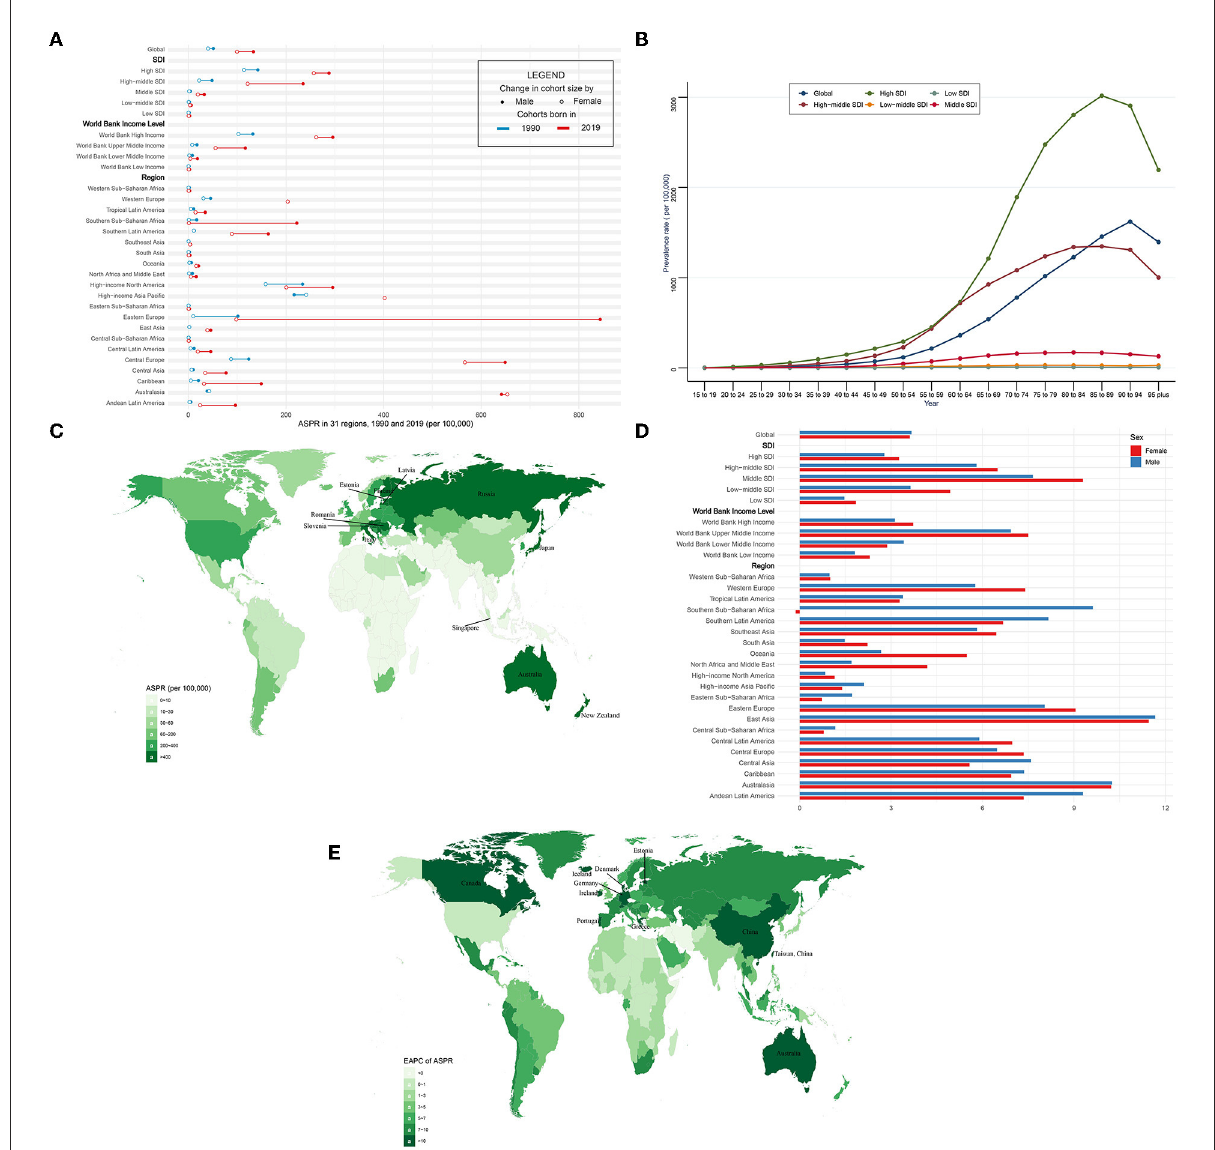
FIGURE2 ASPR and its trend of CAVD. (A) ASPR in 31 regions from 1990 to 2019. (B) Prevalence rate stratified by age in the globe and 5 SDI regions in 2019. (C) ASPR in 204 countries and territories in 2019. (D) EAPC of ASPR in 31 regions from 1990 to 2019. (E) EAPC of ASPR in 204 countries and territories from 1990 to 2019. CAVD, calcific aortic valve disease; ASPR, the age-standardized prevalence rate; SDI, socio-demographic index; EAPC, estimated annual percentage change.